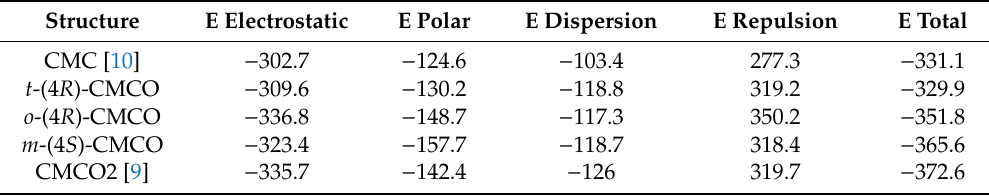
Table 3. Contributions of intermolecular interactions to the packing energies E (kJ / mol) in crystalline structures of S -carboxymethyl-L-cysteine and its oxidation products. Structure E